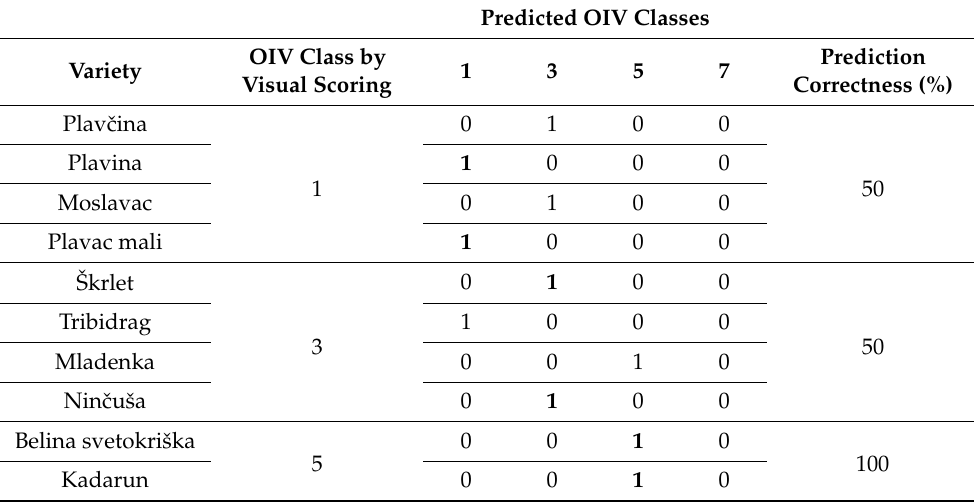
Table 3. Predicted OIV classes for ten native varieties in comparison with visual scoring. (1—variety belongs to this class by prediction; 1 —prediction matches with visual